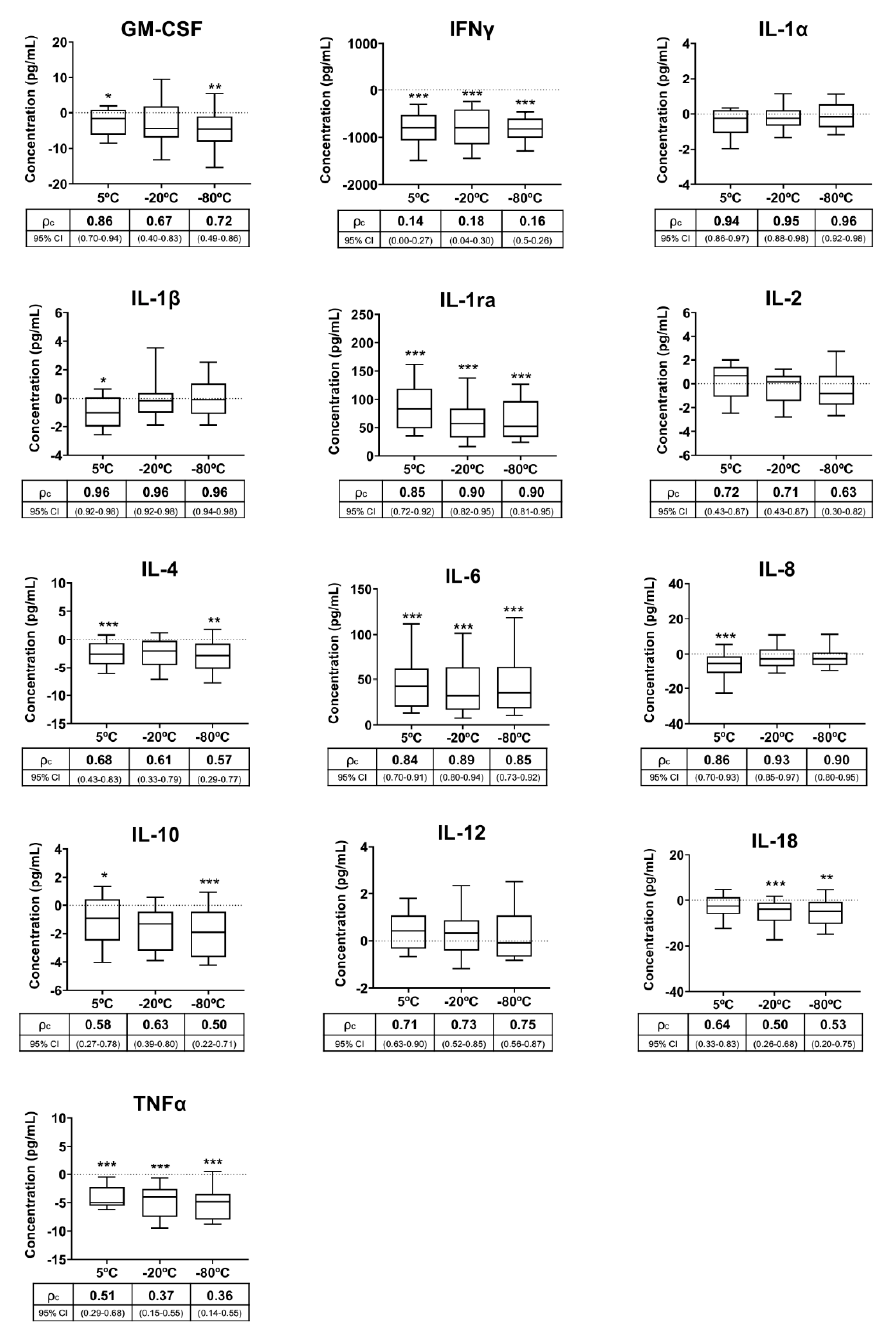
Figure 2. Box-and-whisker plot (horizontal line: median; box: 25/75 percentile; whisker: 10/90 percentile) showing the differences in cytokine concentrations measured in pig seminal plasma samples (SP) stored at 5 °C, − 20 °C and − 80 °C for 72 h with respect to those measured in fresh samples (baseline samples, point 0 in Y axis). Below the X-axis is the concordance correlation coefficient ( ρ c) and 95% confidence interval (CI), showing agreement between cytokine concentrations of baseline and experimental SP samples. Cytokines: Granulocyte macrophage colony-stimulating factor (GM-CSF), interferon-gamma (IFN γ ), interleukin (IL)-1 α , IL-1 β , IL-1ra, IL-2, IL-4, IL-6, IL-8, IL-10, IL-12, IL-18 and tumor necrosis factor- α (TNF α ). Asterisks indicate statistical differences with baseline data. *** p < 0.001; ** p < 0.01; * p < 0.05.